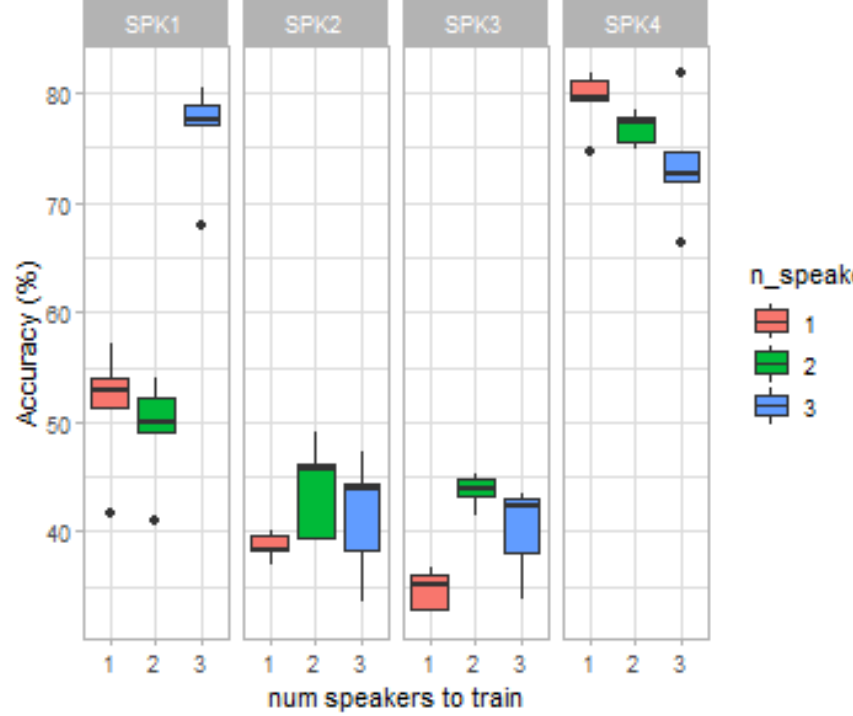
Figure 6. Study of speaker-independent models performance. Accuracy results, per speaker, when considering the remaining one, two, or three speakers for model training and subsequent